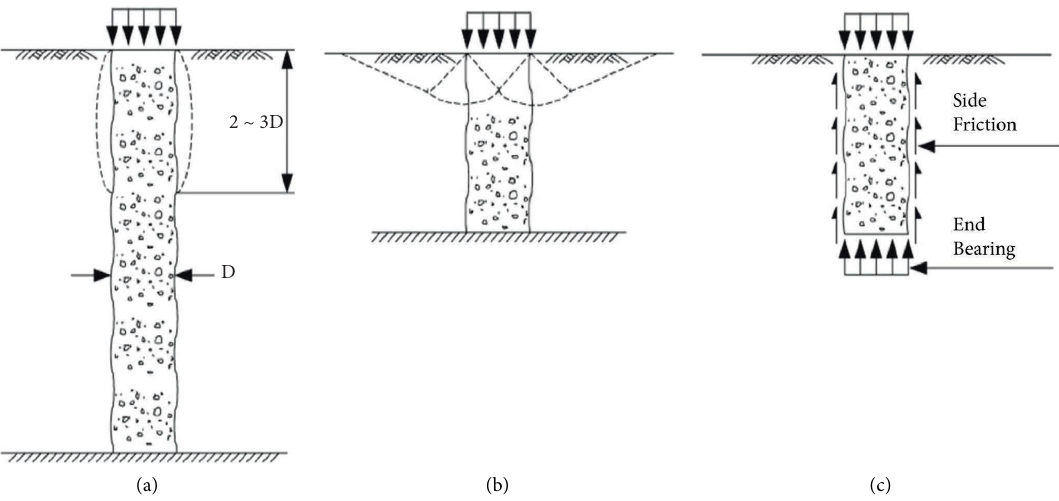
Figure 1: Failure modes of individual columns: (a) bulging failure, (b) shear failure, and (c) punching failure.